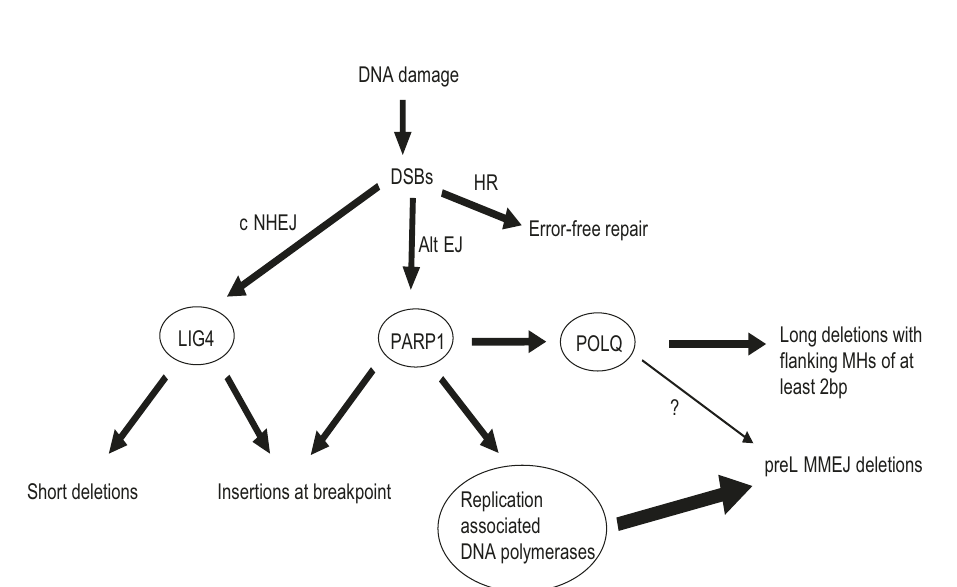
Fig. 8 preL-MMEJ deletions are the result of alternative DSB repair pathway mediated by PARP1 and replication associated DNA polymerases. Three distinct pathways of double strand breaks (DSBs) and their consequent repair outcomes. Classical non-homologous end-joining (c-NHEJ) which involves a fi nal ligation step by LIG4, results in short deletions (<5-bp) or insertions at the breakpoint. Homologous recombination (HR) is an error free repair. Both c-NHEJ and alternative end-joining (alt-EJ) pathways are regulated by PARP1. PARP1 is involved in the formation of c-NHEJ related insertions together with the activation of POLQ and other replication associated DNA polymerases. POLQ mediated pathway generates ≥ 5-bp deletions that are fl anked by microhomologies (MHs) of at least 2 bp. However, preL-MMEJ deletions are only mildly contributed by POLQ (thin arrow) while mainly contributed by other replication associated DNA polymerases (thick